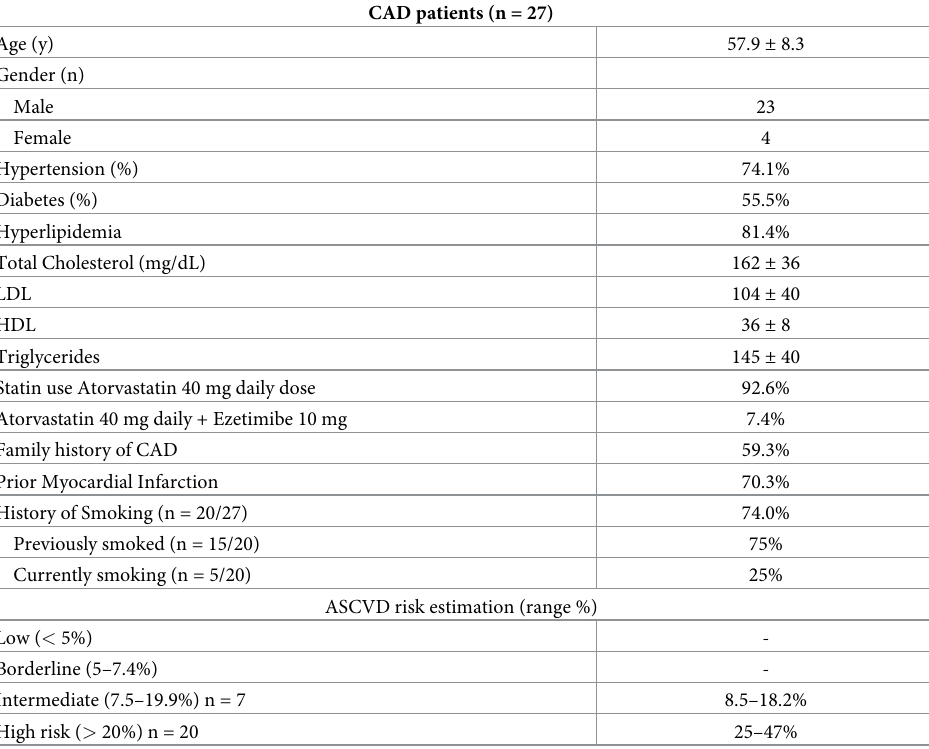
Table 1. Demographic and clinical characteristics of patients in the study.